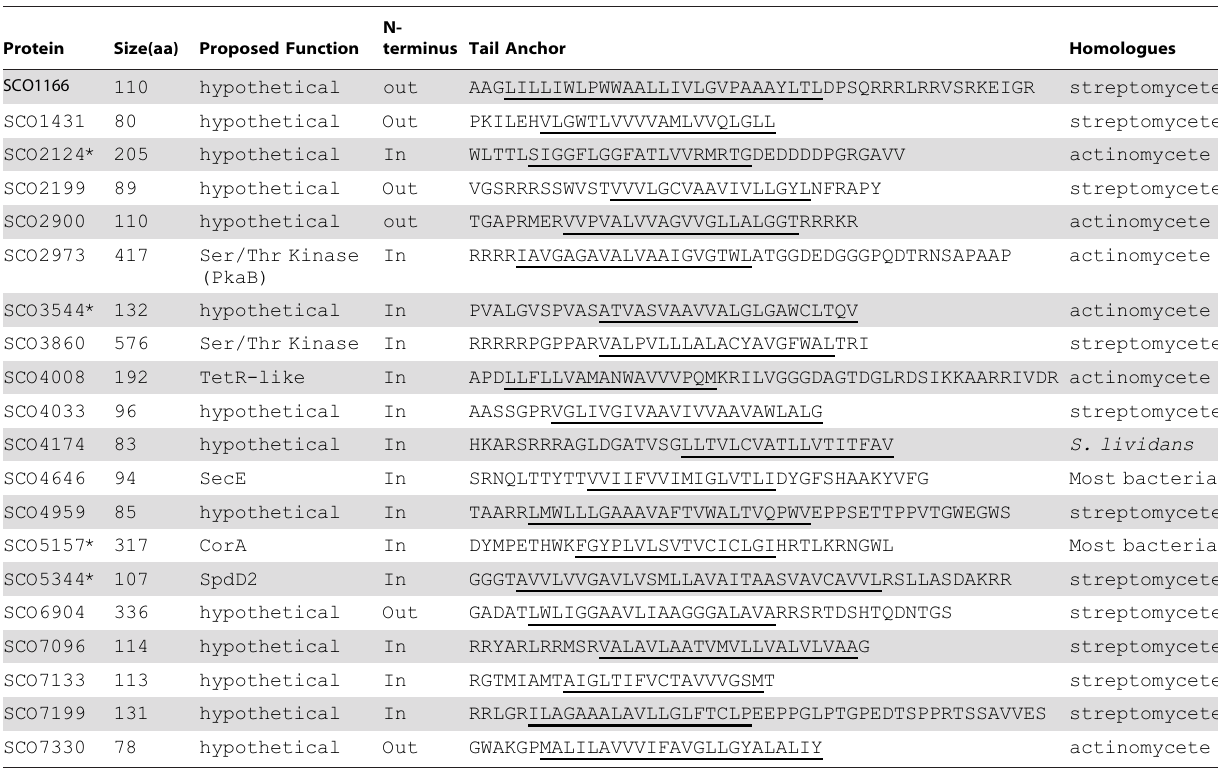
* denotes 2 predicted transmembrane domains at the C-terminus.